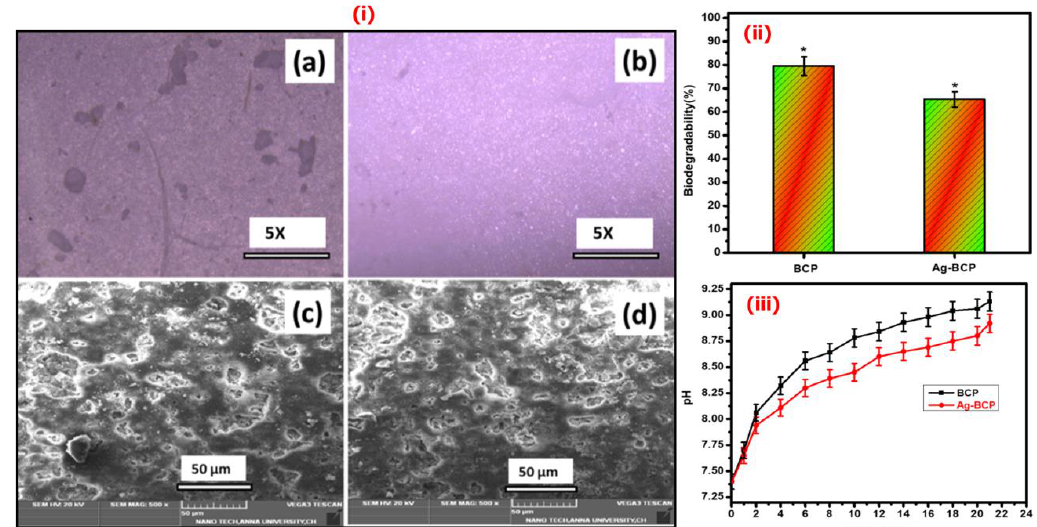
Figure 11. ( i ) Biodegradability investigation using optical microscopy ( a , b ) and SEM analysis ( c , d ) for the BCP and Ag-BCP samples. The degradability efficiency (%) evaluation is determined by the weight-loss method (* denoted as statistical analyses were performed using a one-way analysis of variance (ANOVA) and the data presented are the mean ± standard deviation) ( ii ) and a pH meter investigation ( iii ).